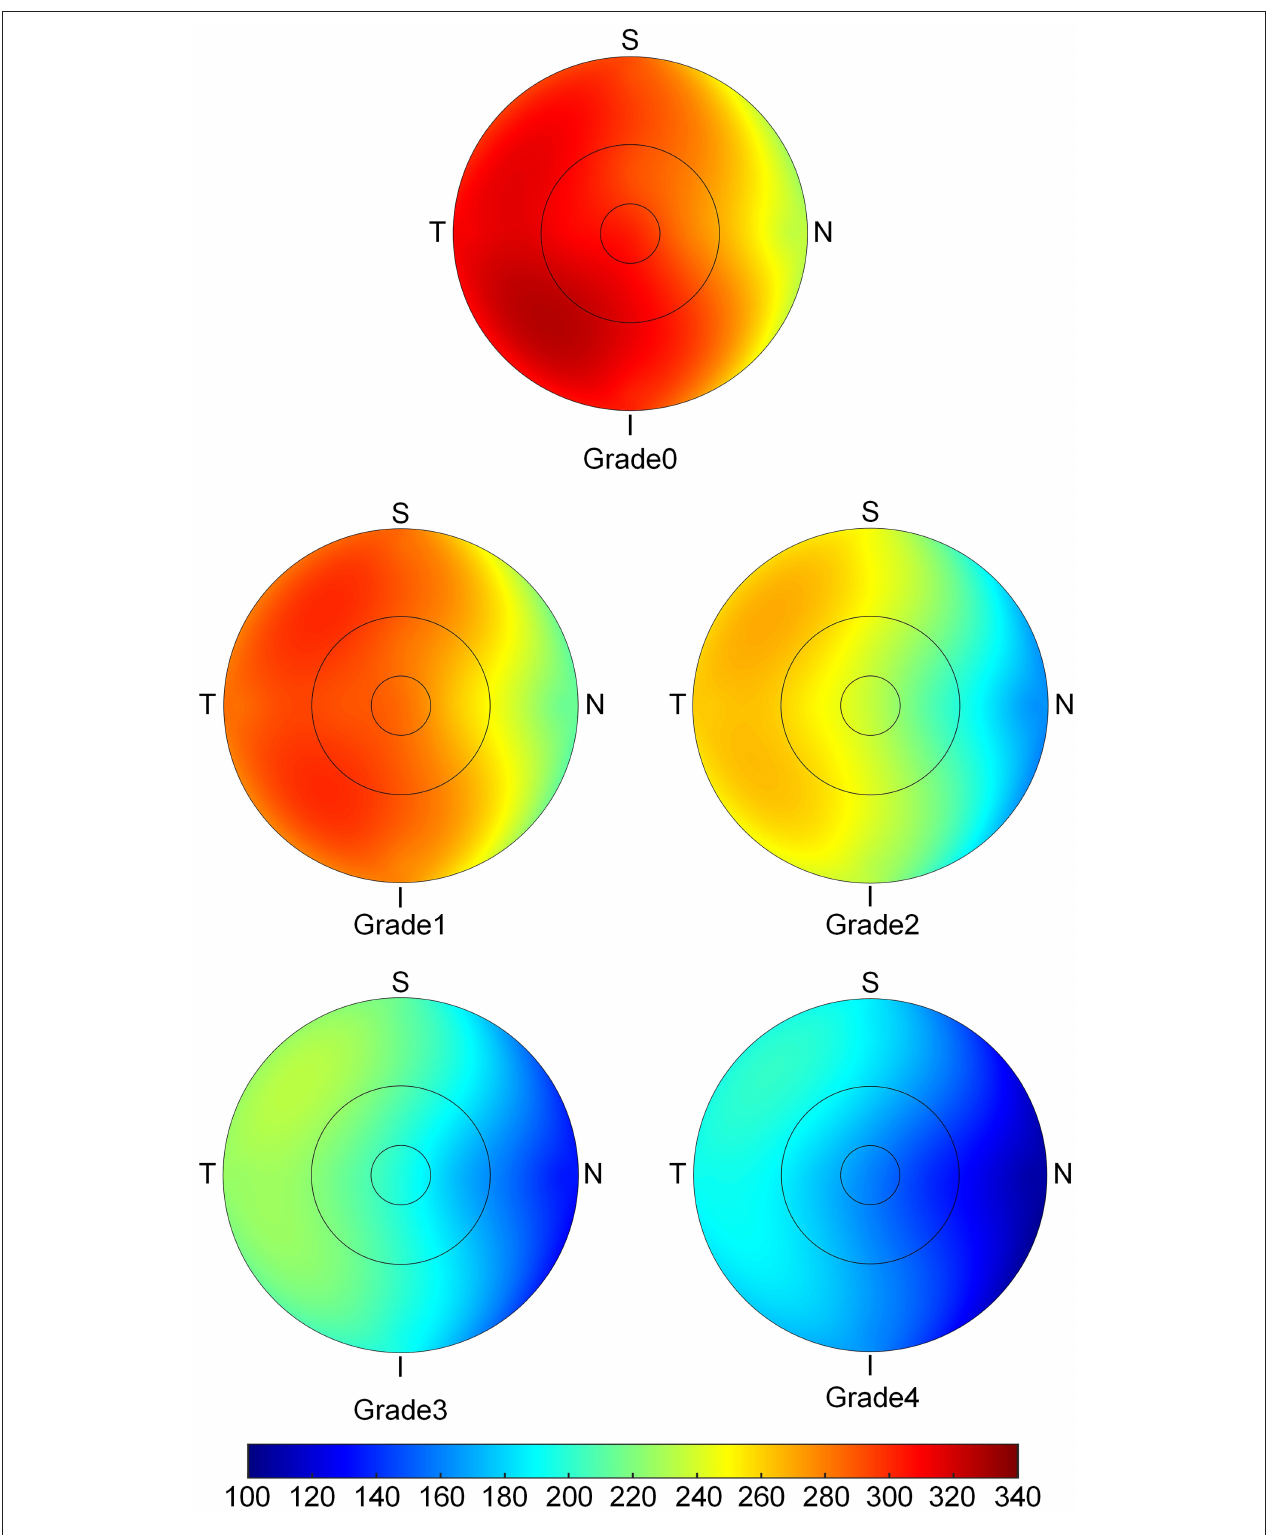
FIGURE 3 | The topographic characteristics of choroidal layer thickness in ETDRS grid centered in fovea, from Grade 0 to Grade 4. The value of choroidal thickness was shown in different color, with color red being the thickest to color blue the thinnest.